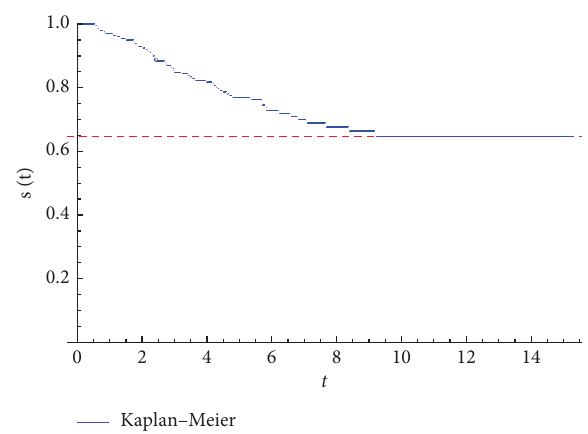
Figure 5: Kaplan–Meier estimator for the melanoma data.